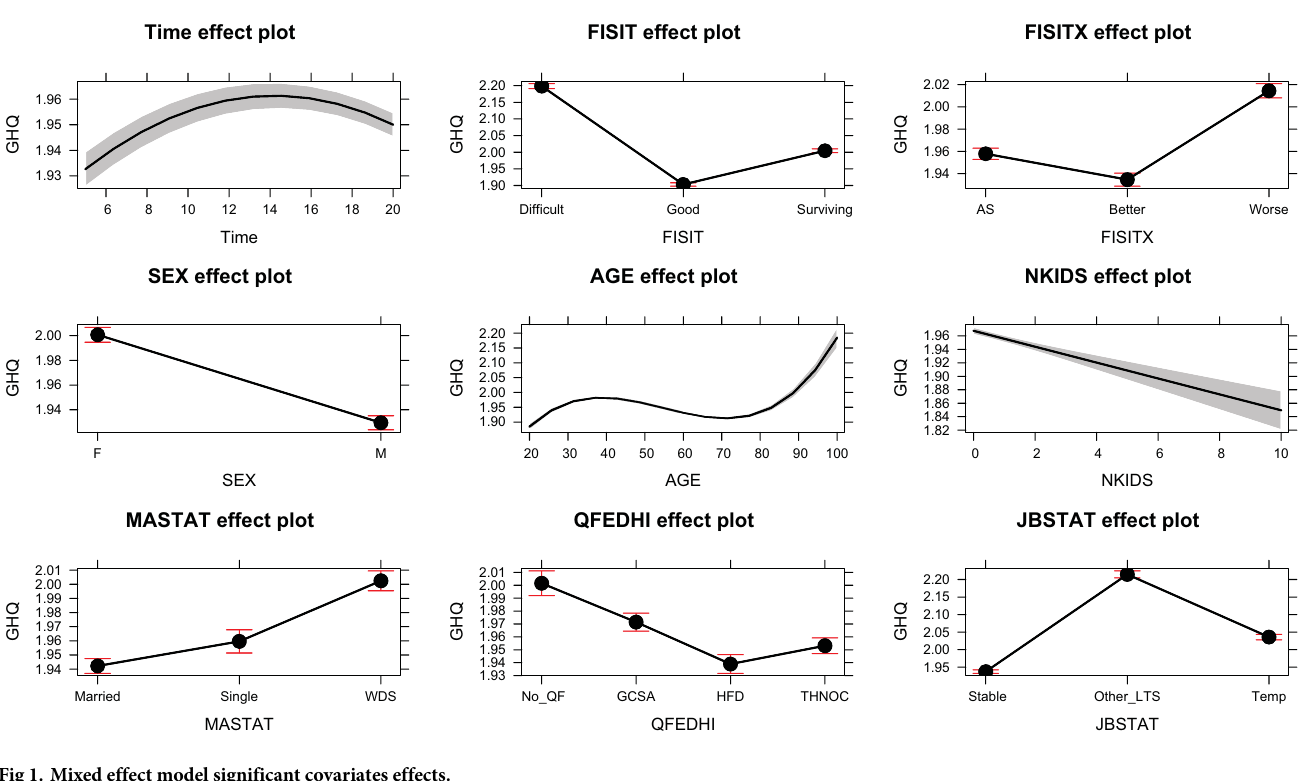
Fig 1. Mixed effect model significant covariates